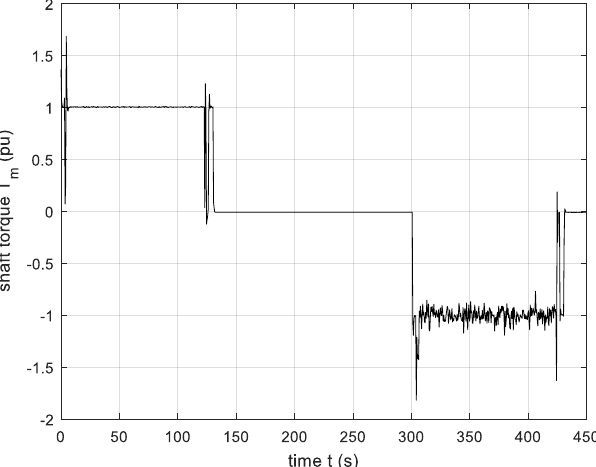
Figure 15. The torque measured on the motor shaft during emulation of the work cycle consisting of lifting and lowering the constant weight, defined in the per-unit system (p.u.). lifting and lowering the constant weight, defined in the per-unit system